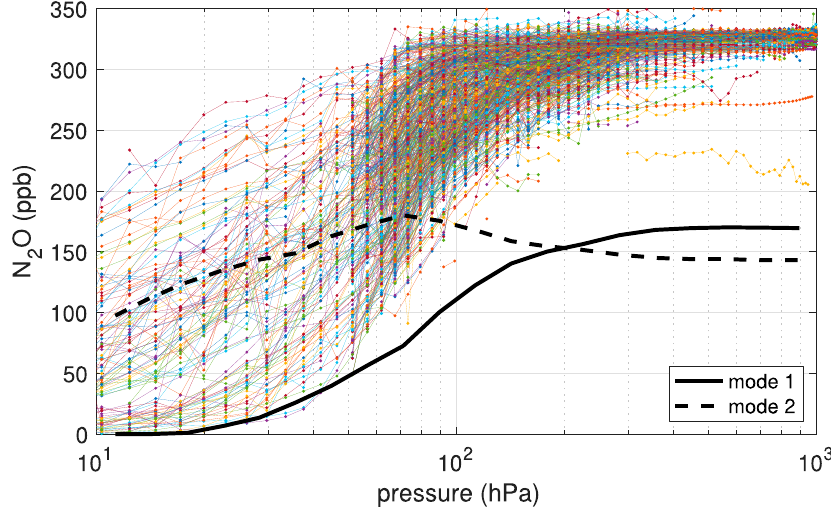
Figure 2. N 2 O mole fraction (in volume mixing ratios with units of parts per billion) versus pressure for all the observations after rebinning all the concentrations onto the same pressure grid. Also shown are the two modes obtained by blind source separation with arbitrary amplitudes.